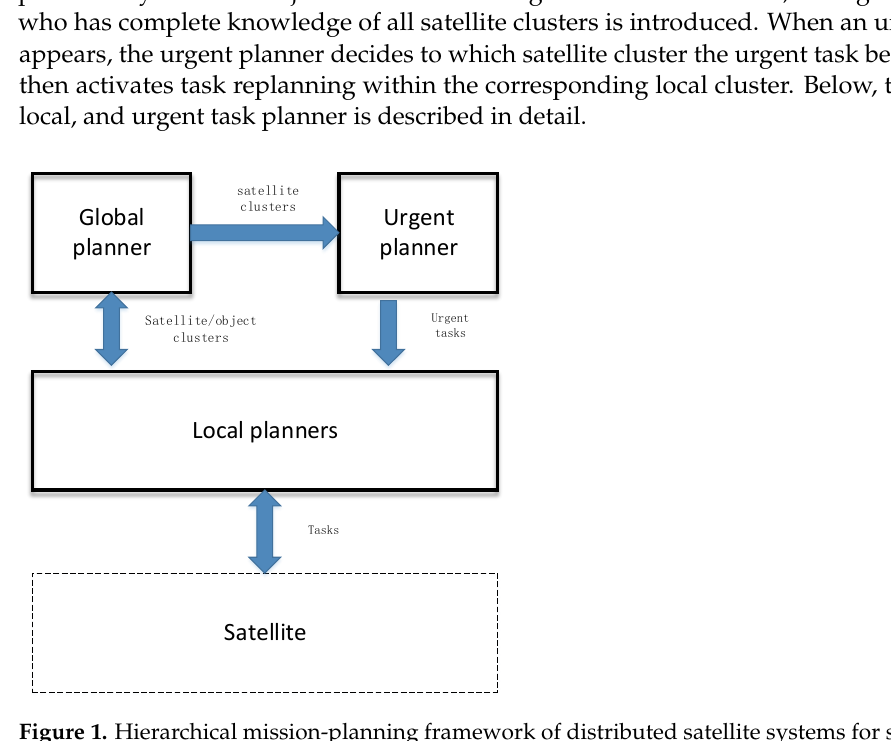
Figure 1. Hierarchical mission-planning framework of distributed satellite systems for space situa- tional awareness